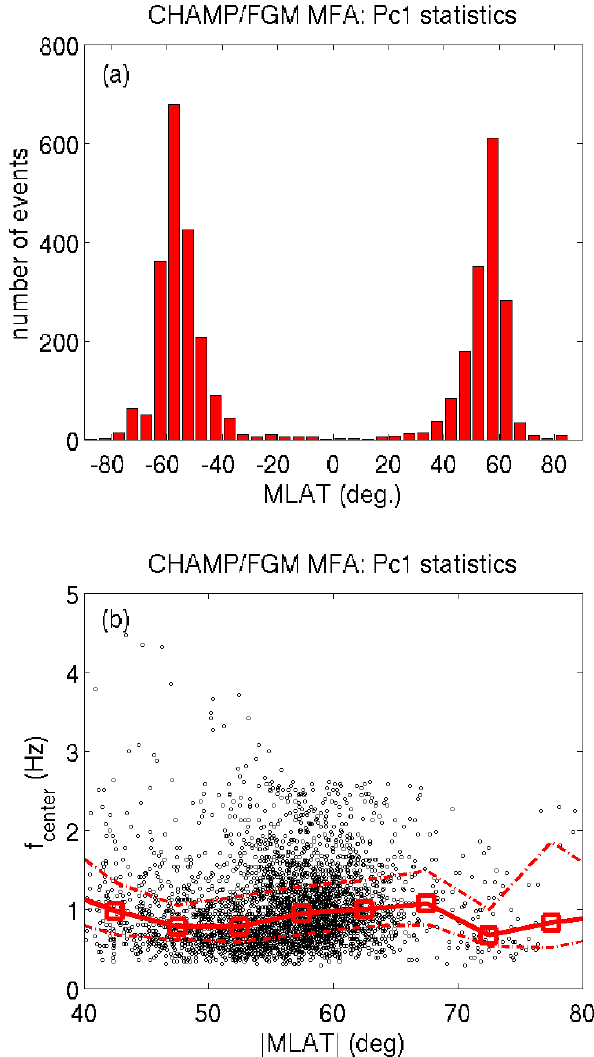
Fig. 7. Latitude dependence of (a) number of detected Pc1 events, and (b) Pc1 center frequency. The black dots in (b) show all the Pc1 events, and the red squares represent median values with their range of quartiles shown as dashed